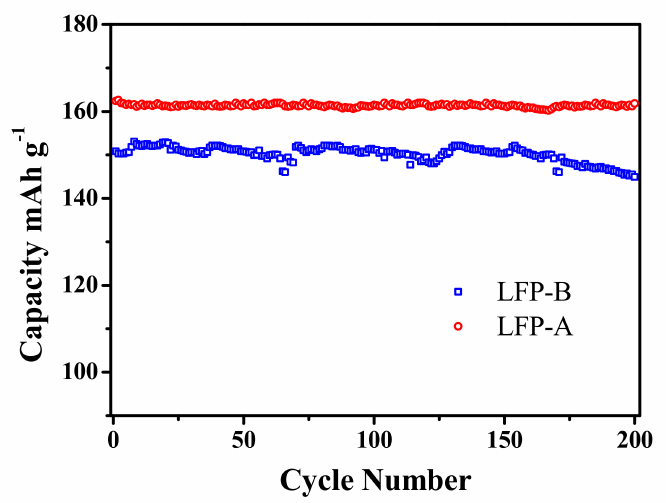
Figure 6. Discharge capacities during continuous cycling of samples at 0.1